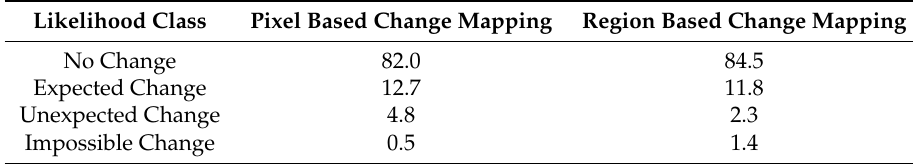
Table 9. The occurrence (%) of each likelihood class in each final change mapping obtained using L2 legend.